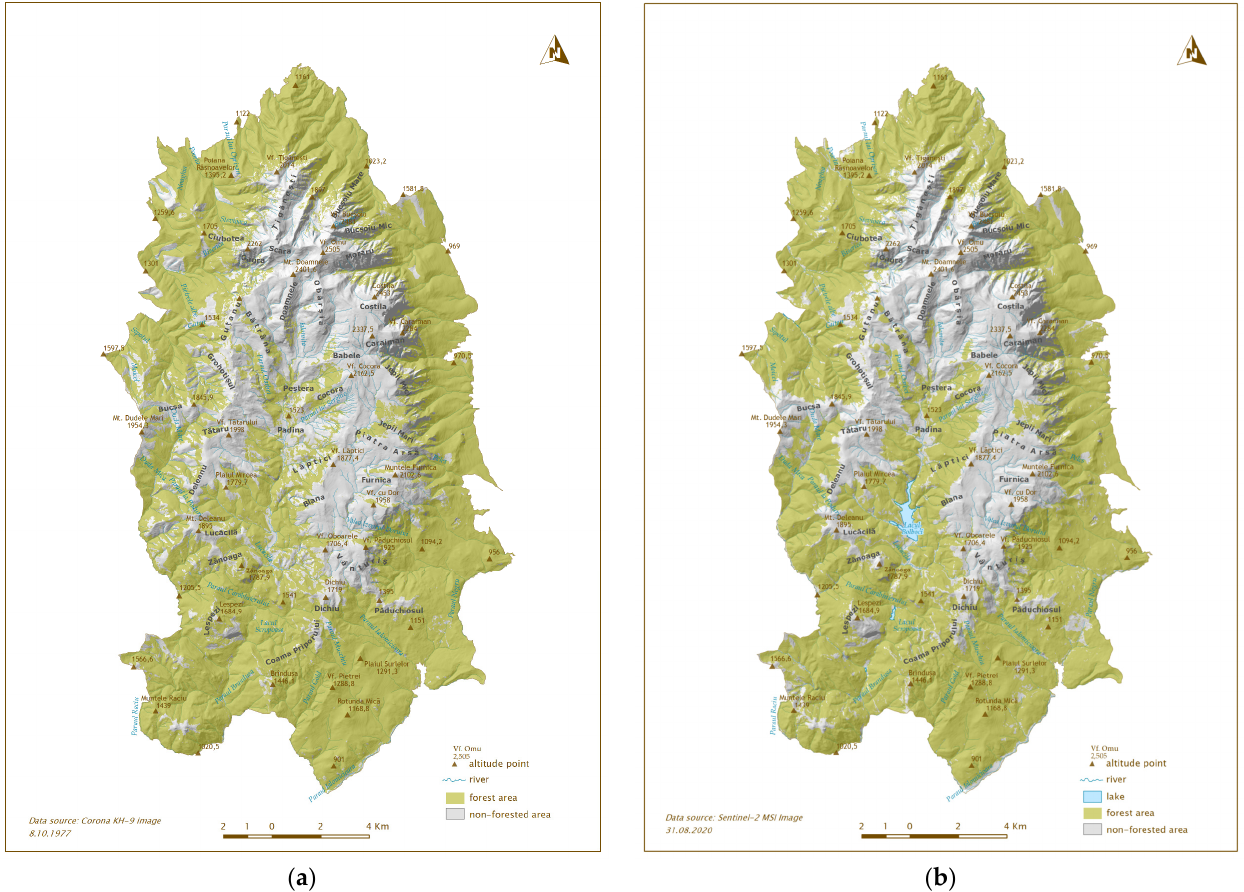
Figure 5. Bucegi Natural Park, forest habitat maps for ( a ) 1977 and ( b ) 2020.